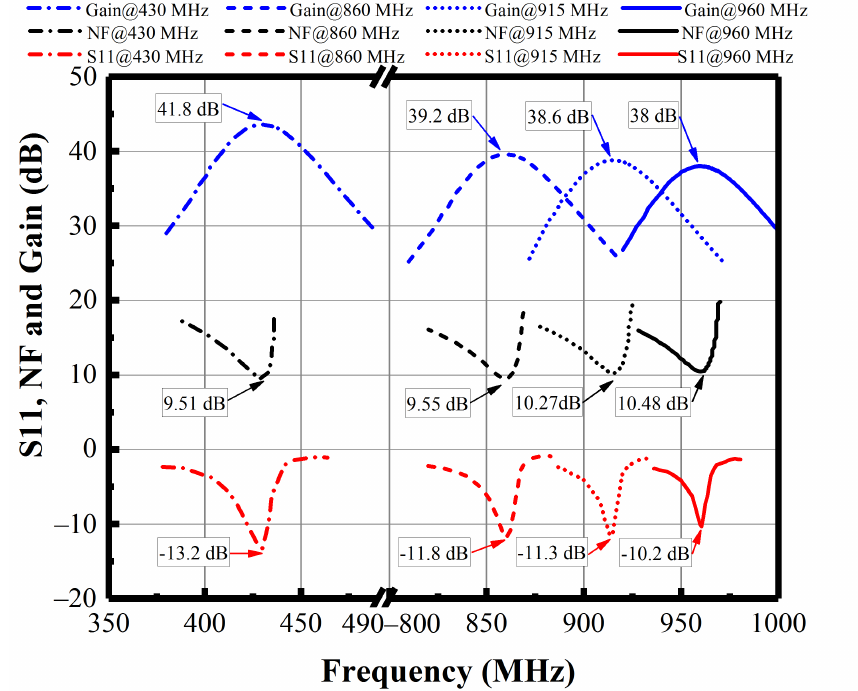
Figure 10. Measurement results of S11, NF and